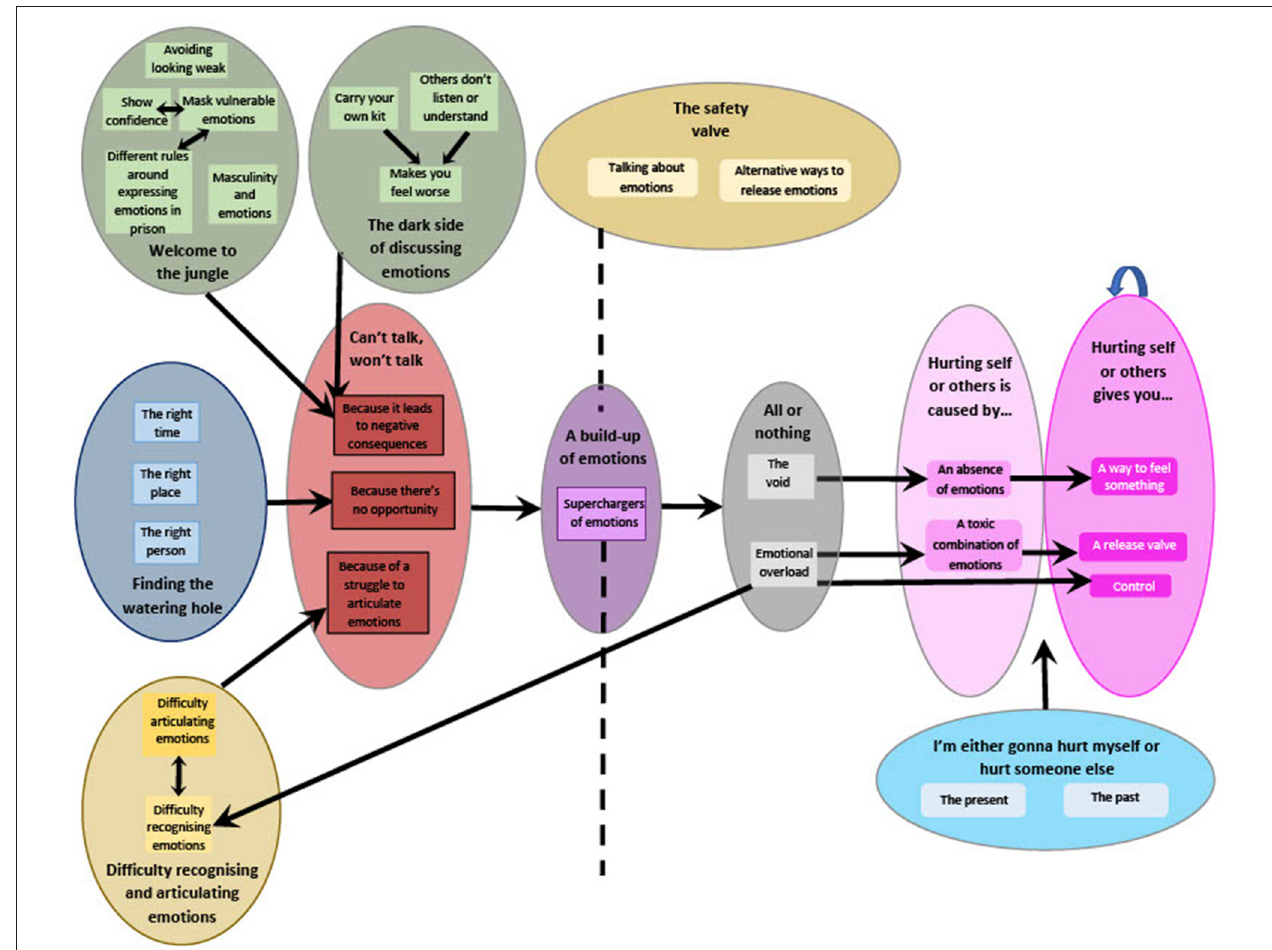
FIGURE 1 | Thematic